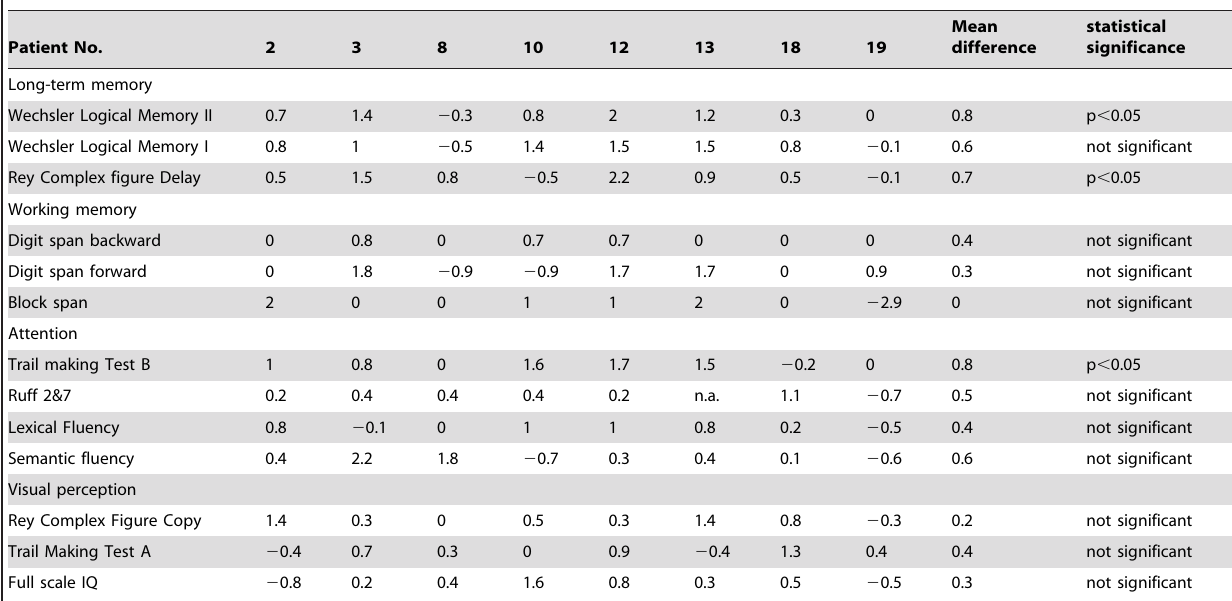
Table 4. Neuropsychological